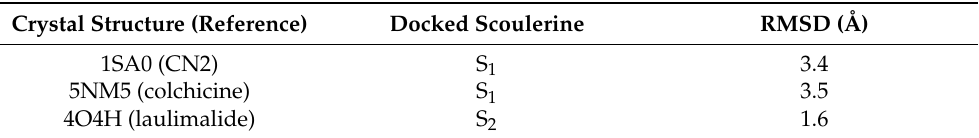
Table 2. RMSD values for scoulerine in S 1 and S 2 with respect to the reference of crystal structures of colchicine, colchicine derivative, CN2, and laulimalide form 5NM5, 1SA0, and 4O4H PDB files, respectively. Crystal Structure (Reference) Docked Scoulerine